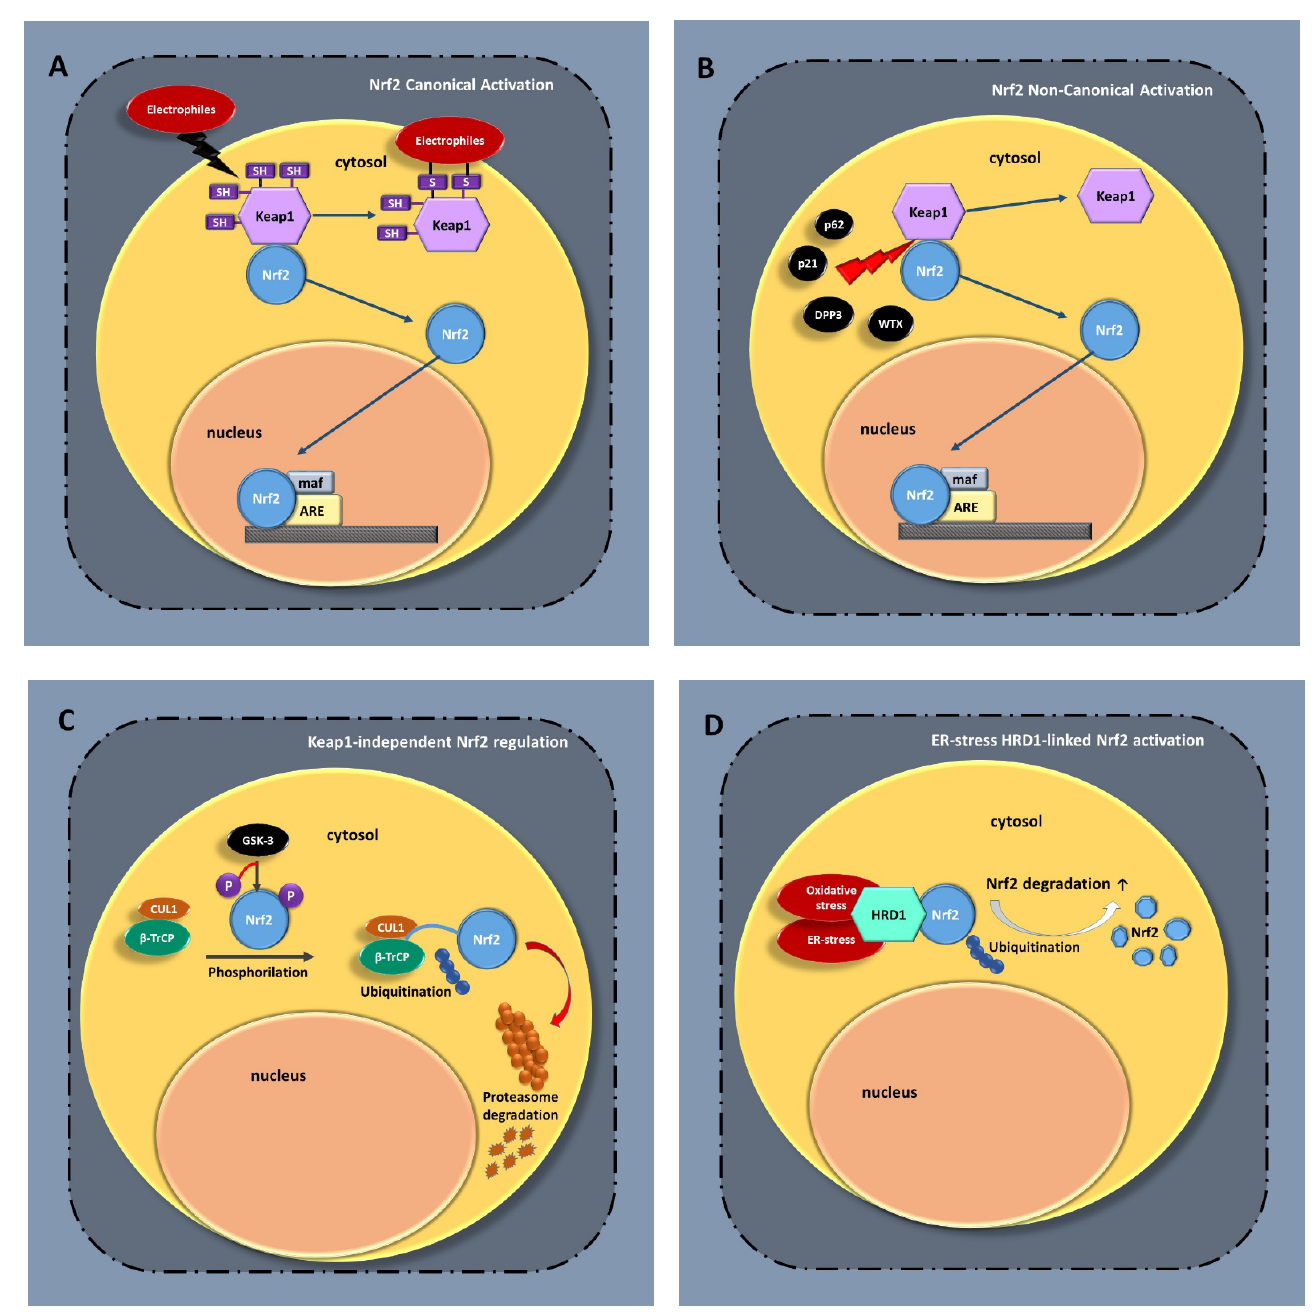
Figure 1. ( A ) Canonical mechanism of Nrf2 activation; ( B ) Non-canonical mechanism of Nrf2 activation; ( C ) Keap1-independent Nrf2 regulation; ( D ) ER-stress HRD-1-linked Nrf2 activation. Nrf2—nuclear factor erythroid 2–related